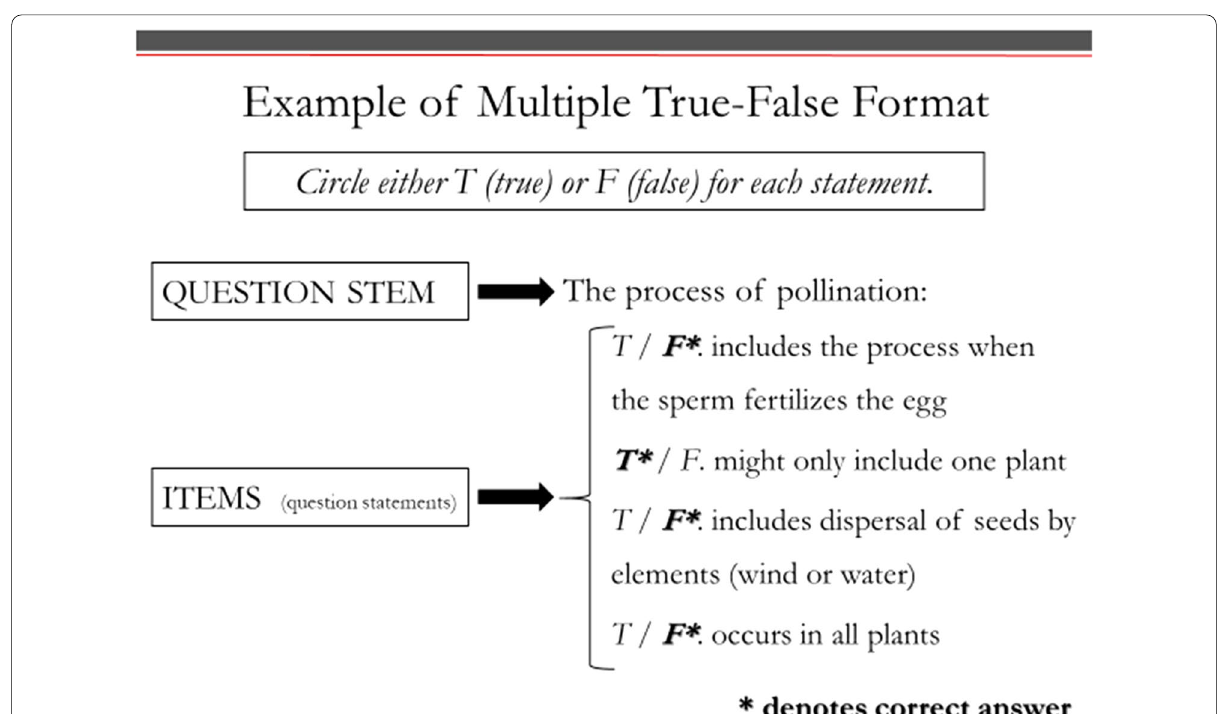
Fig. 1 Example of a multiple true–false item included in the Pollination Systems Knowledge Assessment